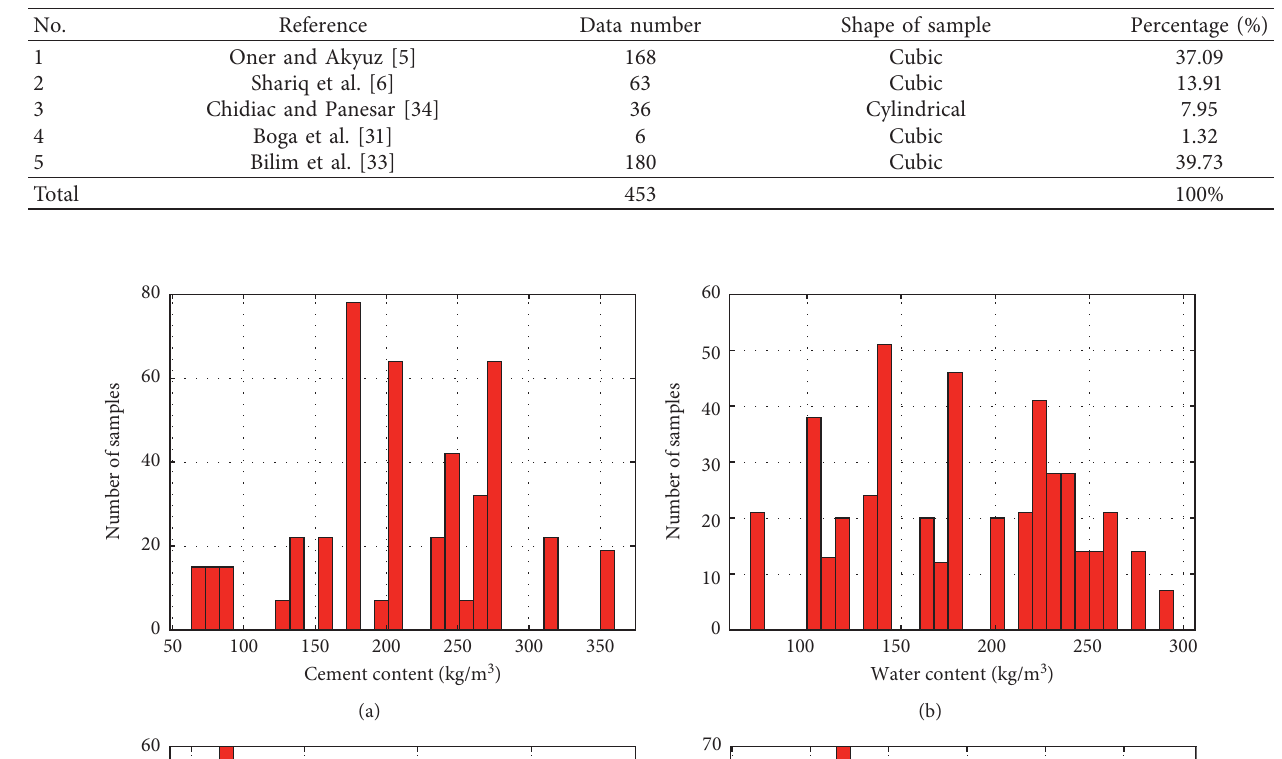
Table 1: Detail of database